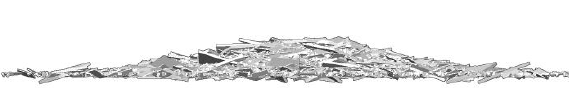
Figure 4. Gray value histogram of simulated debris amplitude samples (orange) in comparison to vegetation (left) and gravel